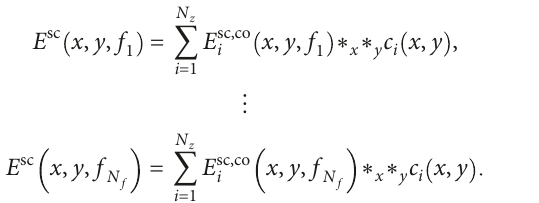
to measure the PSF i